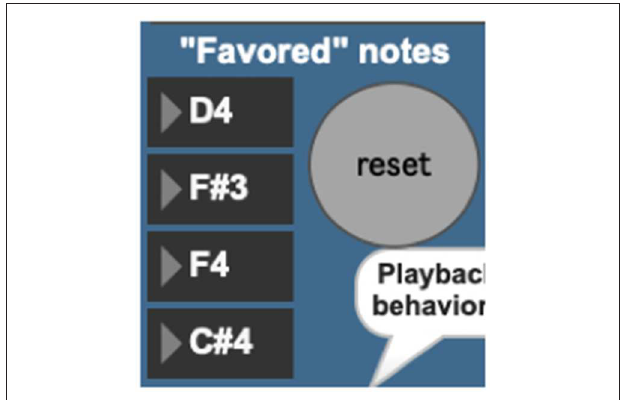
FIGURE 10 | AvatarPlayer’s four favored notes, chosen via a machine-learning database.